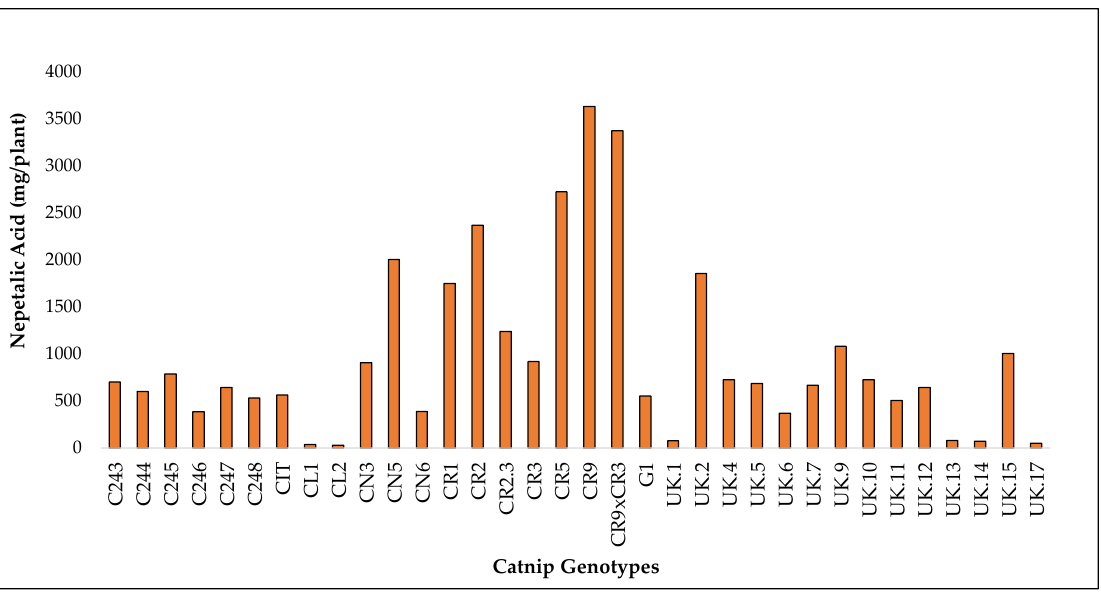
Figure 5. Accumulated biomass in different catnip genotypes after 3 successive harvests (2017 1 and 2 and 2018). Pittstown, NJ, USA.